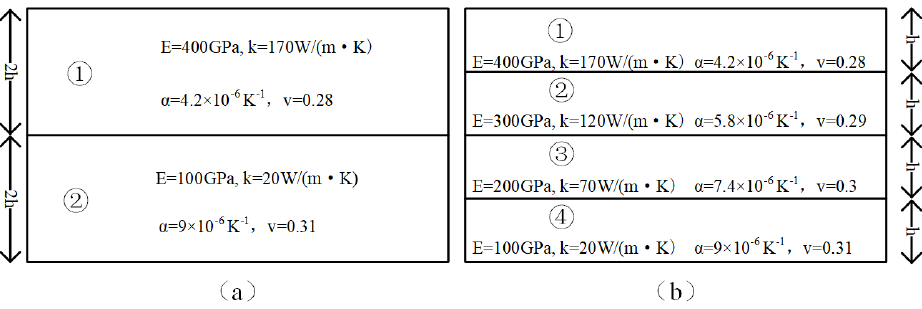
Figure 15. Composite material parameters distribution. ( a ) double-layer material; ( b ) Four-layer ma-